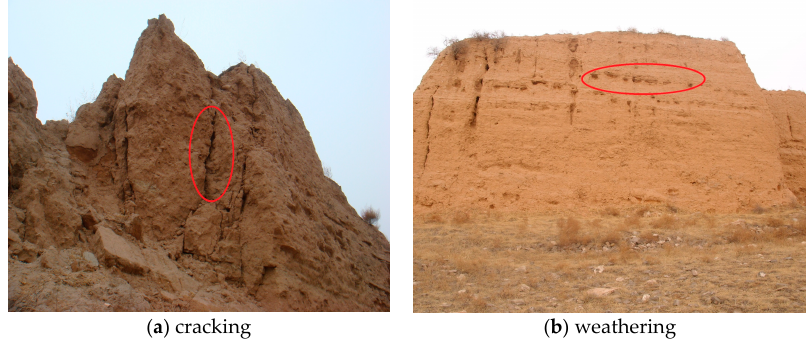
Figure 1. Cracking and weathering damage in Ming Dynasty Great Wall.